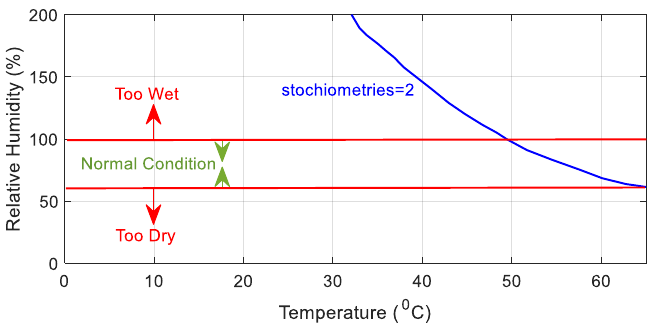
Figure 6. ThresholdforrelativehumiditywithrespecttostacktemperatureofPEMFCwithstoichiometry2. Figure 6. Threshold for relative humidity with respect to stack temperature of PEMFC with stoichiometry 2.